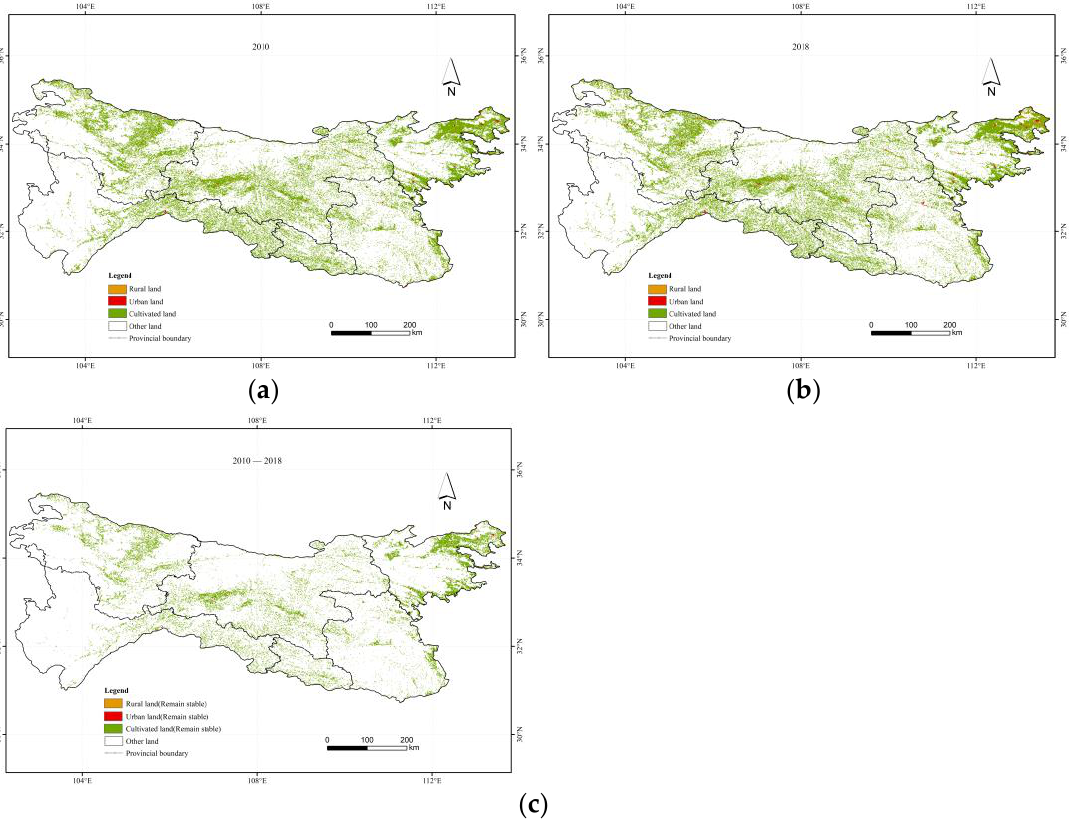
Figure 2. Land use in the Qinling – Daba mountains after reclassification to four types: cultivated land, urban land, and rural land in ( a ) 2010 and ( b ) 2018. ( c ) Extraction of cultivated land, urban land, and rural land that remained unchanged during 2010 – 2018 in the Qinling – Daba mountains.